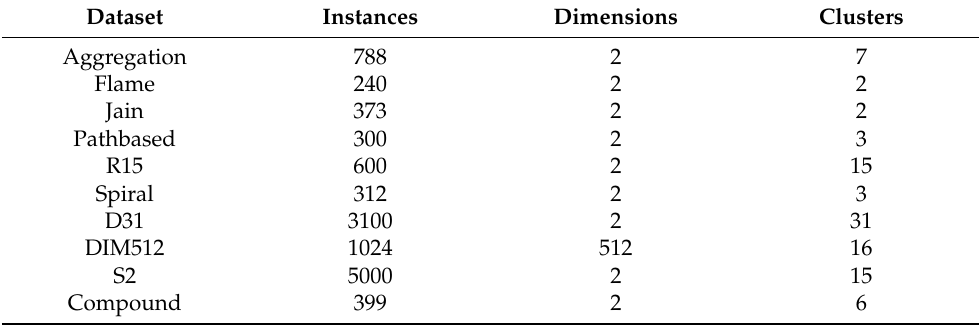
Table 2. Synthetic datasets.